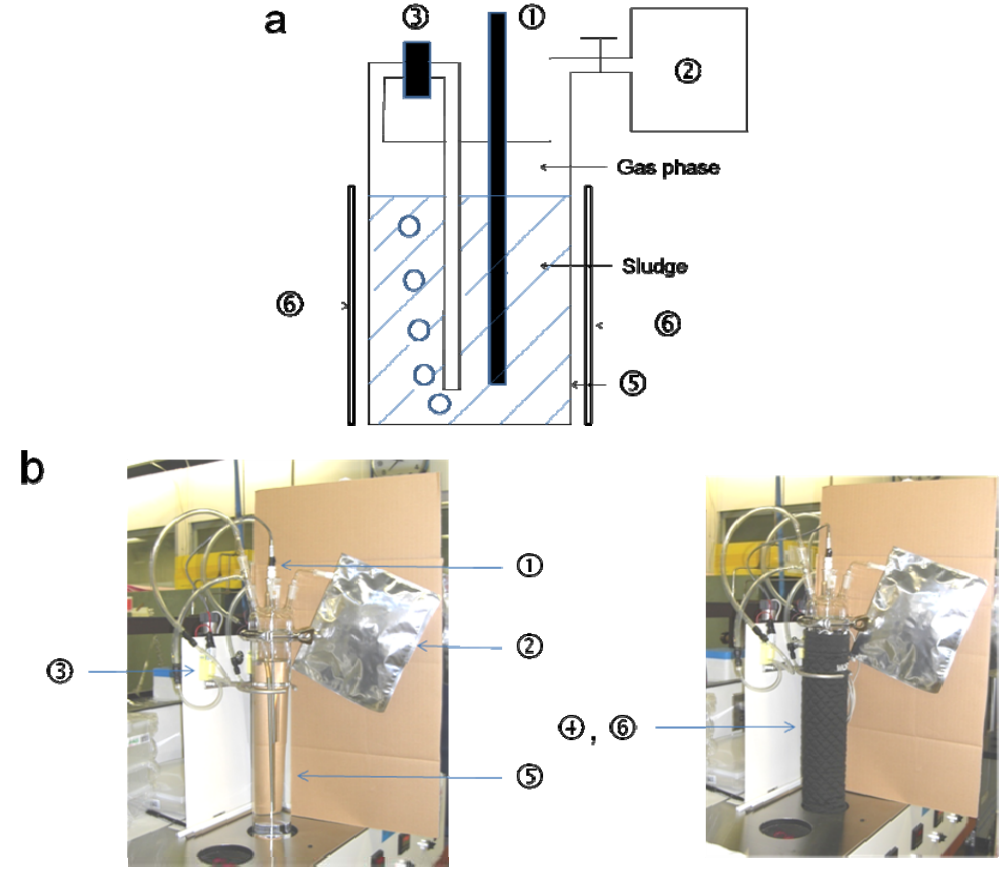
Figure 1. System of MODA-B apparatus. (a) Schematic of MODA-B; (b) Pictures of